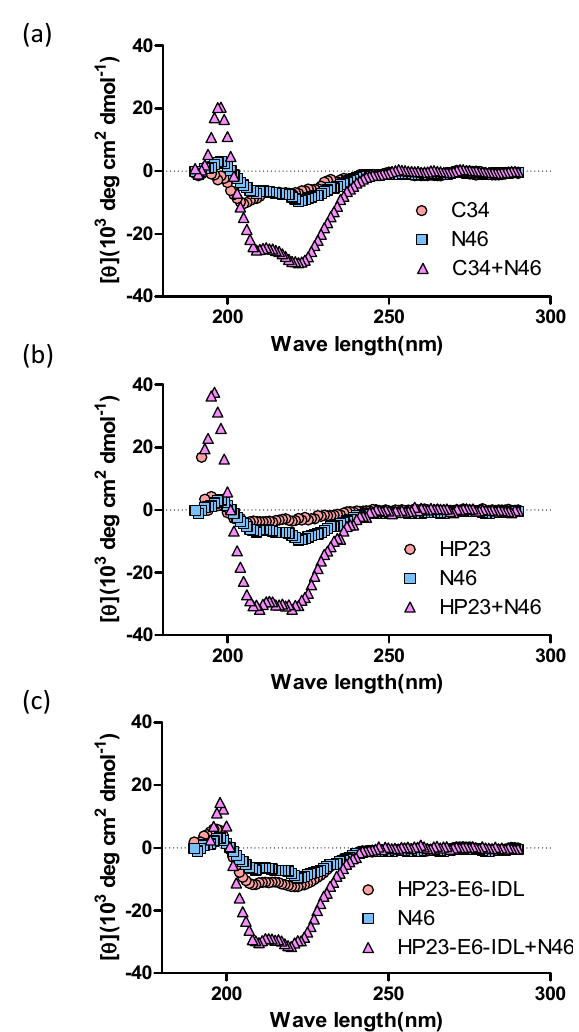
Figure 2. Secondary structures of CHR peptide-NHR peptide complexes. ( a – c ) Circular dichroism (CD) spectroscopy results for the complexes formed by N46 and C34, HP23, and HP23-E6-IDL are shown. The circular dichroism spectra of these complexes displayed typical double minima at 208 and 222 nm for the α -helical feature. C34 was used as a positive control.